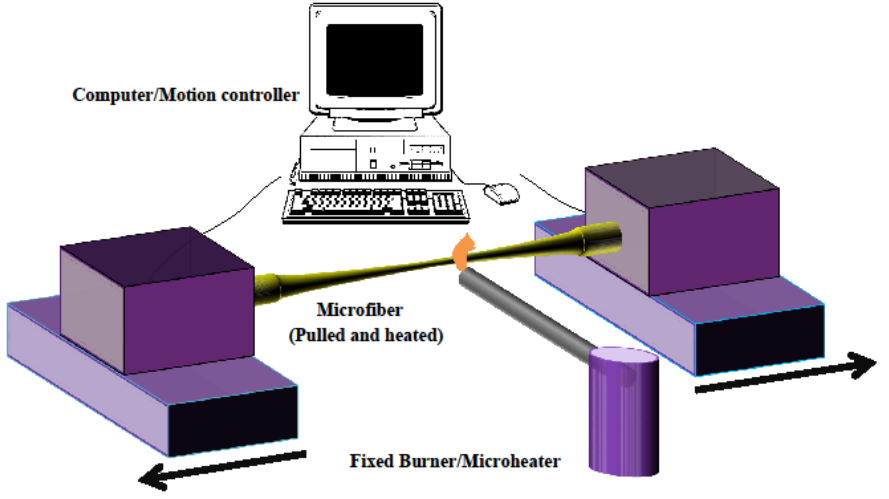
Figure 2. The flame brushing technique: a flame travels under an optical fiber clamped at its extremity onto two computer-controlled stages which are moving apart.